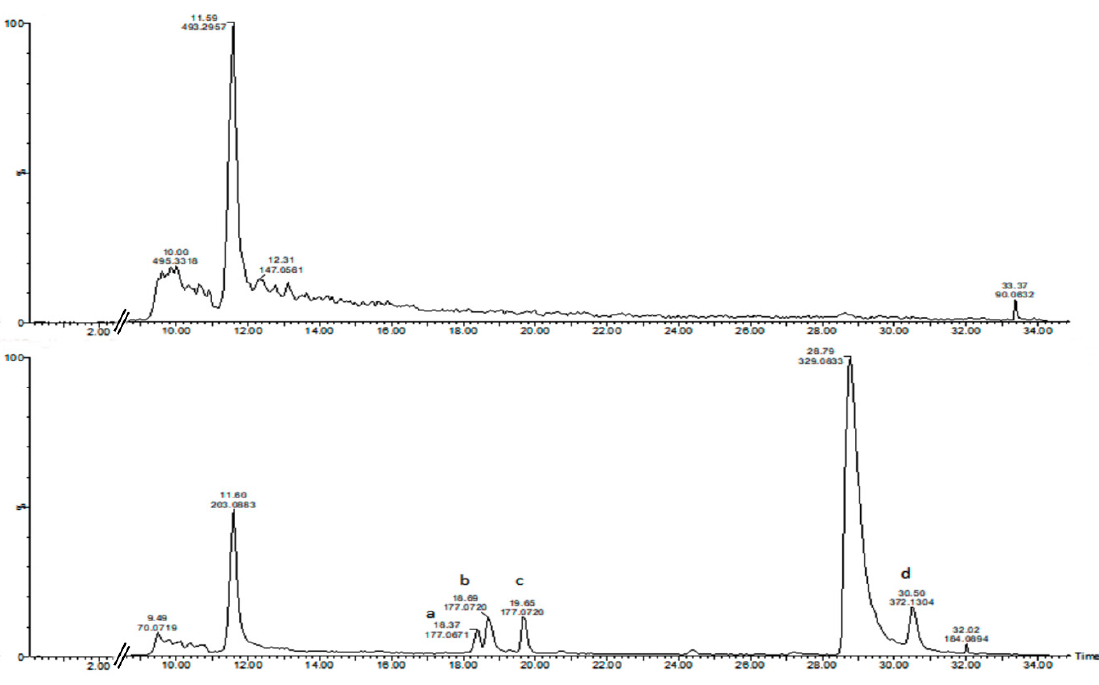
Figure 3. Extracted MS chromatograms at MS/MS (MSe) level of the precursor specie 372 m/z . A comparative extracted chromatogram for control untreated ( top MS/MS trace) and treated with azoxystrobin ( lower MS/MS trace) extracted and analyzed after 96 h. Four potential azoxystrobin metabolites are differentially displayed containing the 372 m/z species as visualized by the related extracted chromatogram at m/z 372 with different retention times: a) RT 18.36 min; b) RT 18.68 min; c) RT 19.72 min; and d) RT 30.5 min, being RT 28.79 min related to the azoxystrobin itself.